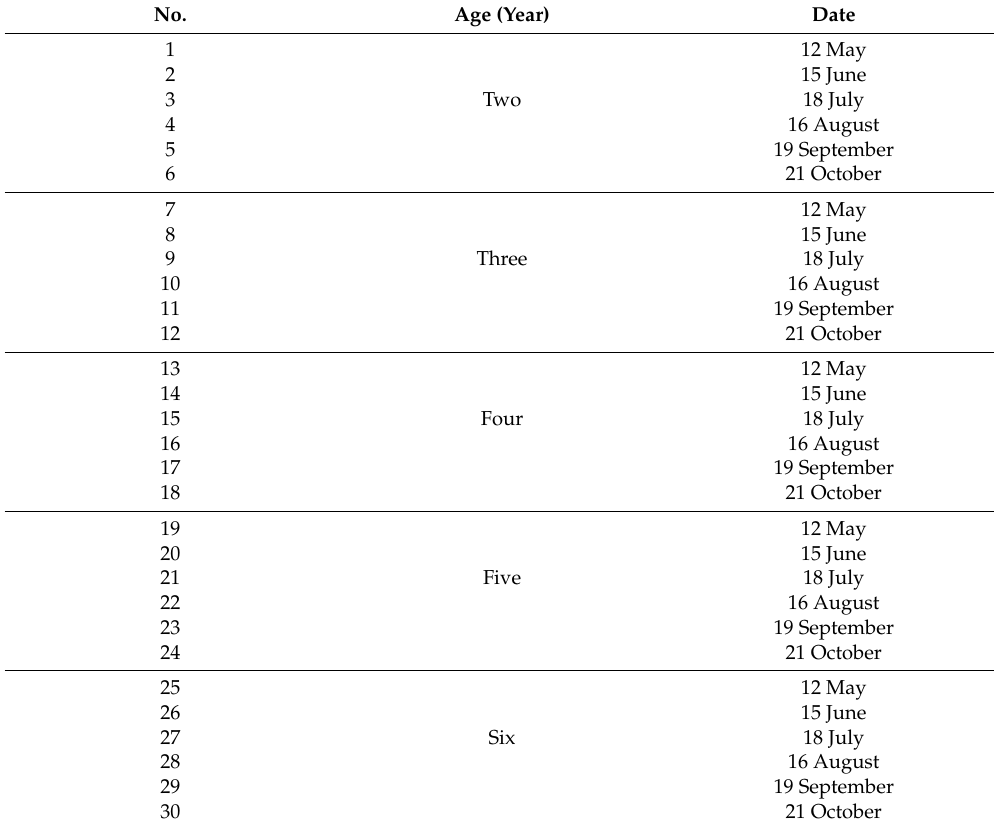
Table 2. Panax ginseng root sample collection